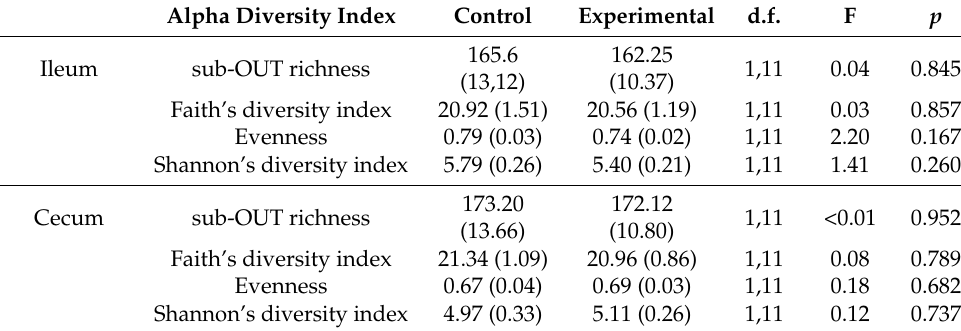
Table 2. General Linear Models exploring the effects of 30-days treatment in alpha diversity indexes in ileum and cecum of laying hens. Treated hens received in their basal diet supplemented with a commercial Alliaceae extract. Significant values were set at 0.05. Degrees of freedom (d.f.) are also shown.